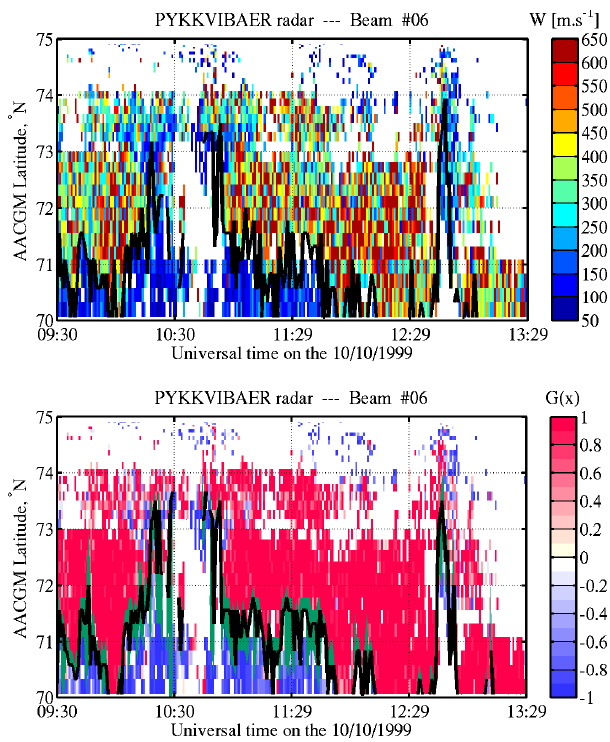
Fig. 8. SWB determination between 09h30-13h30 for the Octo- ber 10, 1999 event, as observed by ykkvibaer beam #06, us- ing two methods. The upper panel shows the SWB (thick black Þ line) obtained by applying a direct threshold to the spectral width (W ∗ = 200ms − 1 ), as determined from the FitACF routine. The colour code refers to the spectral width. The lower panel shows the SWB identified from the discriminant function G(x) , with its confidence interval